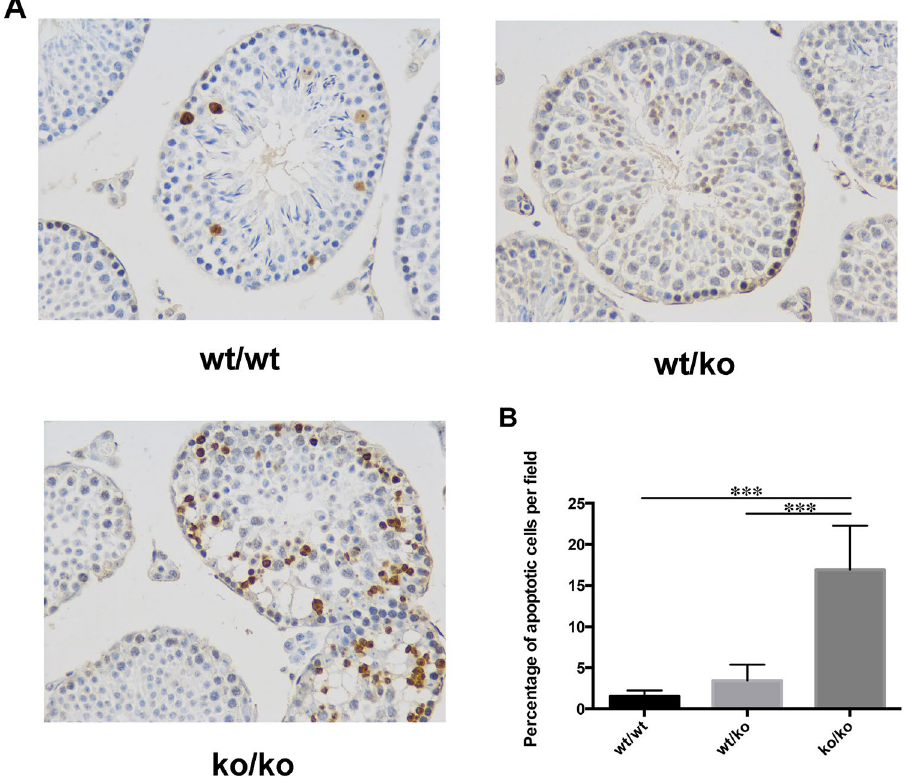
Figure 3. Absence of GGNBP2 increases apoptosis in testis. ( A ) Apoptosis analysis of the three murine genotypes. From top to bottom are the testis of wild-type, heterozygous and GGNBP2 KO mice. 10 × 40, LM. ( B ) Quantification of the percentage of apoptotic cells per field (field of view at 400x magnification) in the intersecting surface of the testes. The graph indicates the mean ± SEM of 5 independent fields. Statistical analysis was performed using Student’s t-test. *** P <